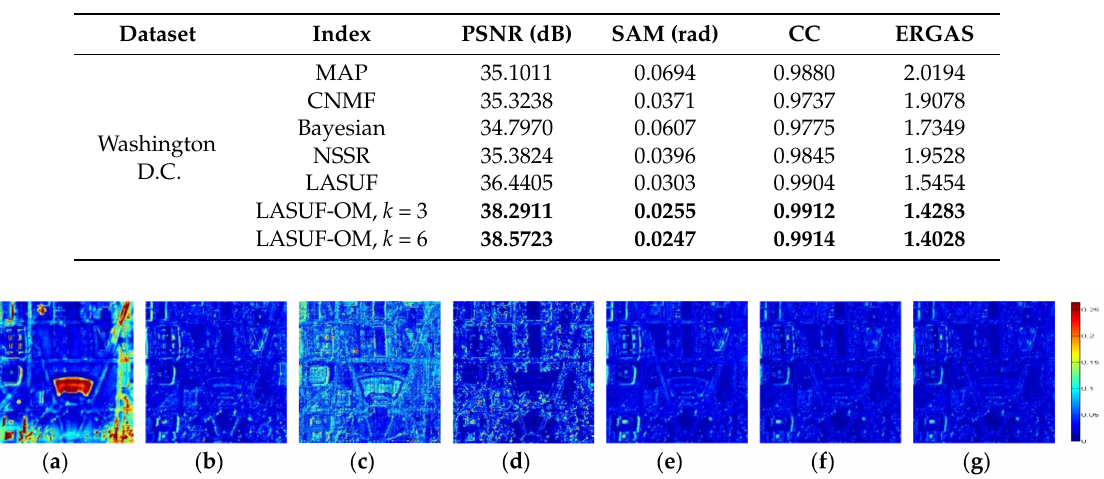
Table 5. Comparison of average statistical indexes of different methods of Washington D.C. (1/2 Subpixel Shift).